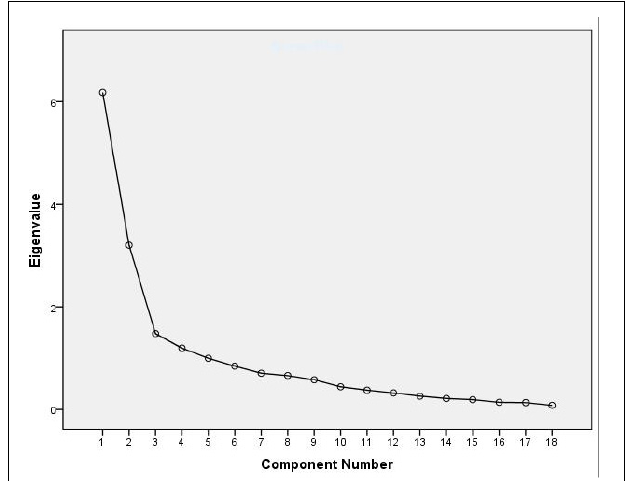
FIGURE 2 | Scree plot showing the number of components that explain the variance in MG behavior. A factor analysis was conducted on 18 scales of MG behavior. The scree plot shows that two of these factors explain most of the variability, as the line begins to straighten after the second factor.